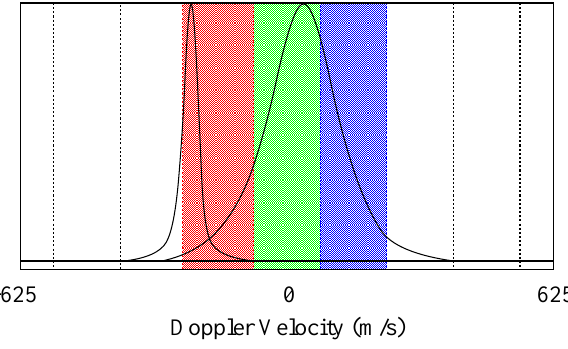
Fig. 3. Depiction of the parsing of the Doppler spectrum into 8bins. Idealized type I (narrow) and type II (wide) Doppler spectra are shown for reference. Three separate images representing the signal- to-noise ratio in the three lowest frequency bins are constructed. These are color-coded blue (for blue-shifted echoes), green, and red (for red-shifted echoes) and superimposed to create the final